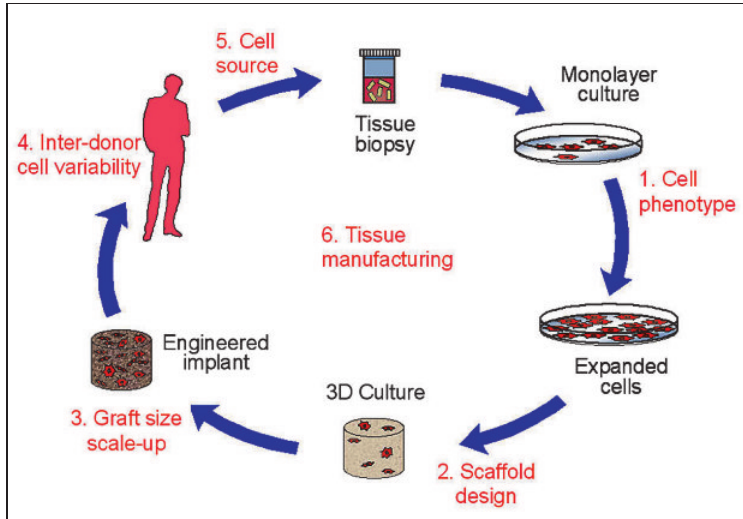
Tissue engineering of autologous cartilage grafts.The chart displays the different phases in a typical approach to engineering of autologous grafts (blue arrows) and the most critical factors entailed (1. to 6., discussed in section 2 of this